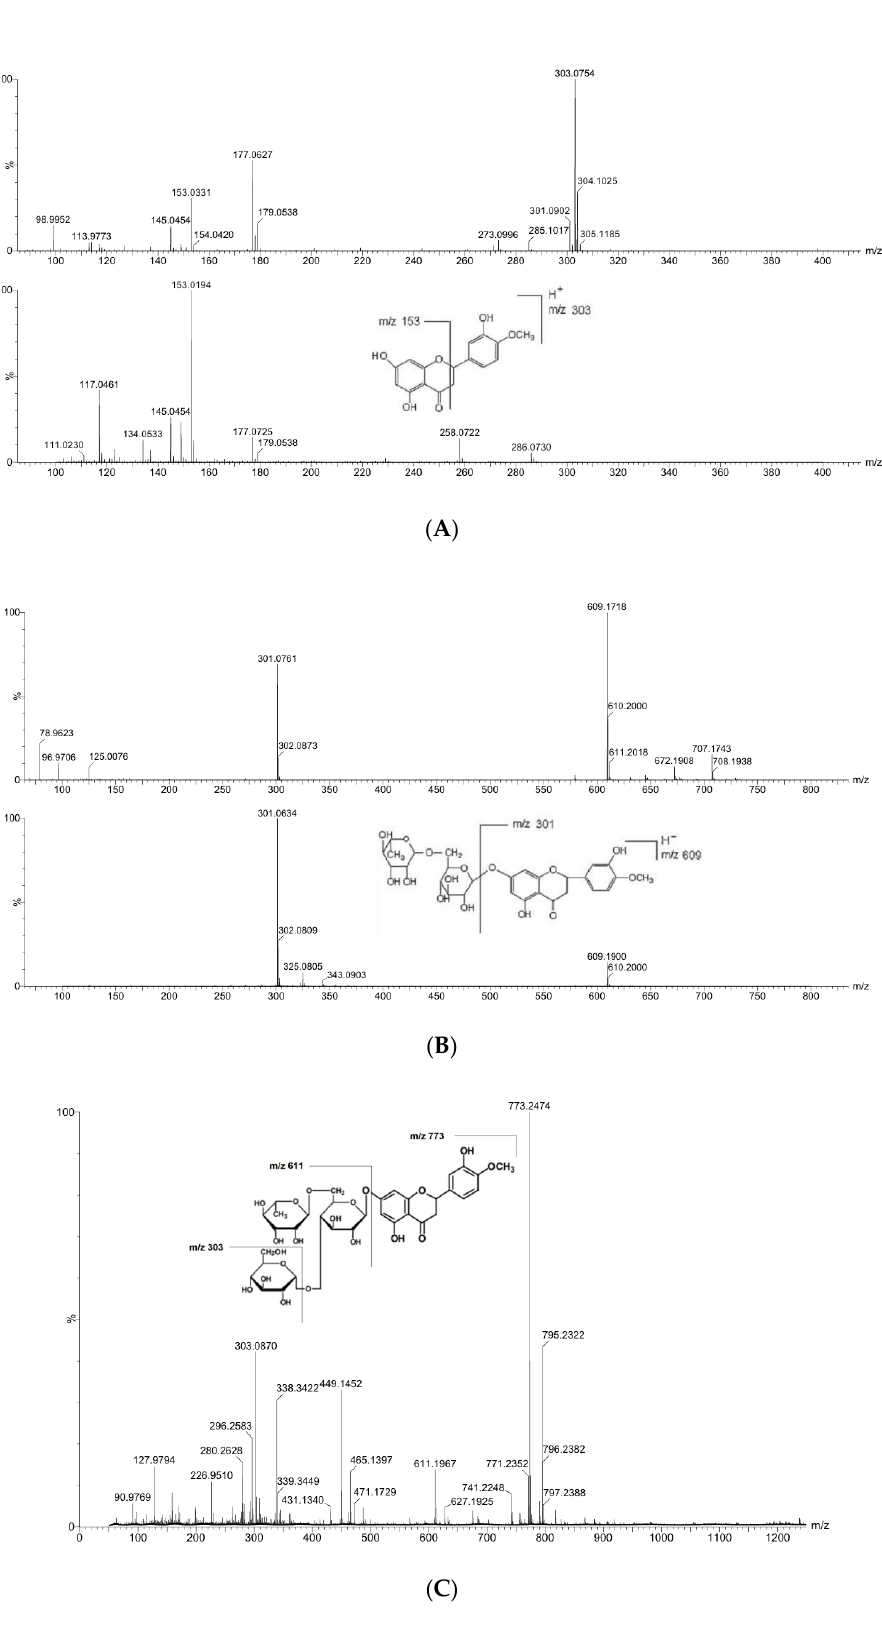
Figure 4. Mass spectra and fragmentation of prepared hesperetin, hesperidin and hesperidin glu- coside by LC-MS-(MS) analysis. ( A ) Spectra of hesperetin, ( B ) spectra of hesperidin, ( C ) spectra of hesperidin